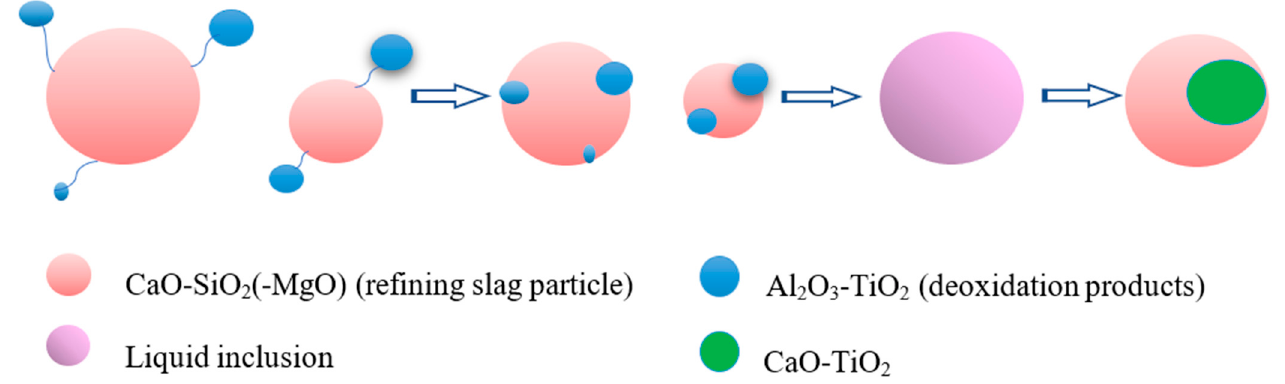
Figure 8. The formation and evolution mechanism of CaO-Al 2 O 3 -SiO 2 -(MgO)-TiO 2 inclusion during the whole refining process.